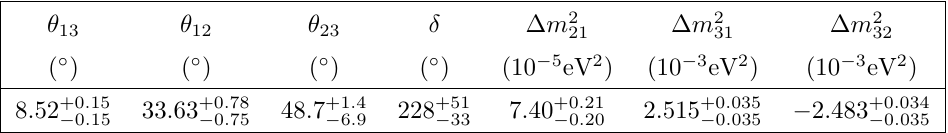
Table 1 . Best (cid:12)t and 1 (cid:27) ranges from a global (cid:12)t to neutrino data